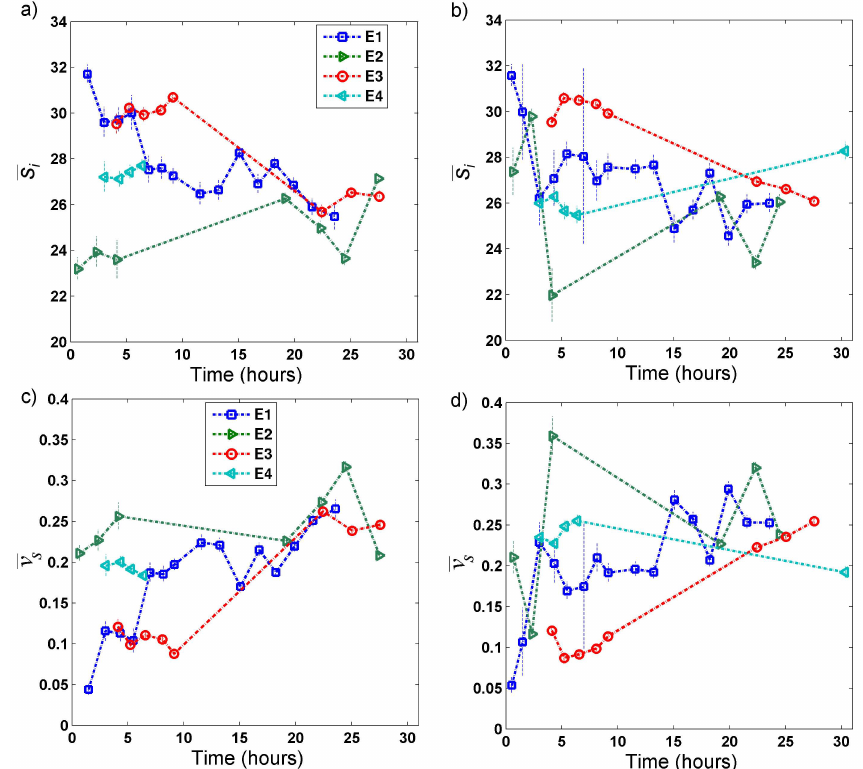
Fig. 5. Time evolution of the thickness-weighted mean frazil ice salinity (thick dashed lines, derived from Eq. 5) for all experiments (a) tank A, (b) tank B as well as mean frazil ice volume fraction (c) tank A, (d) tank B. Note that all salinities in E4 started with 2gkg − 1 higher salinity and are therefore normalized by 33/35.38 to allow comparison. Thin vertical lines indicate the standard error of the tank average, assuming a 0.3cm maximum uncertainty in ice thickness